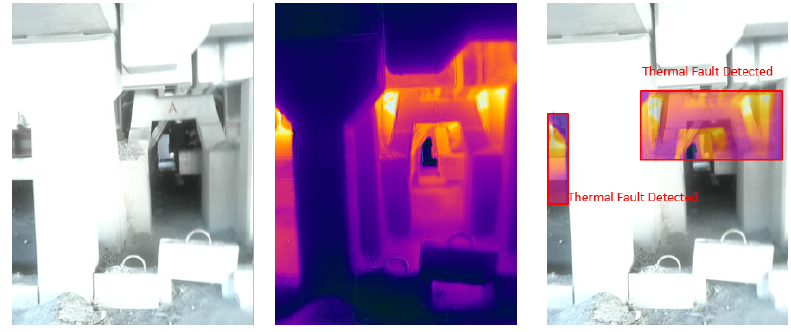
Figure 23. Thermal anomalies detection on-site for test run 1.